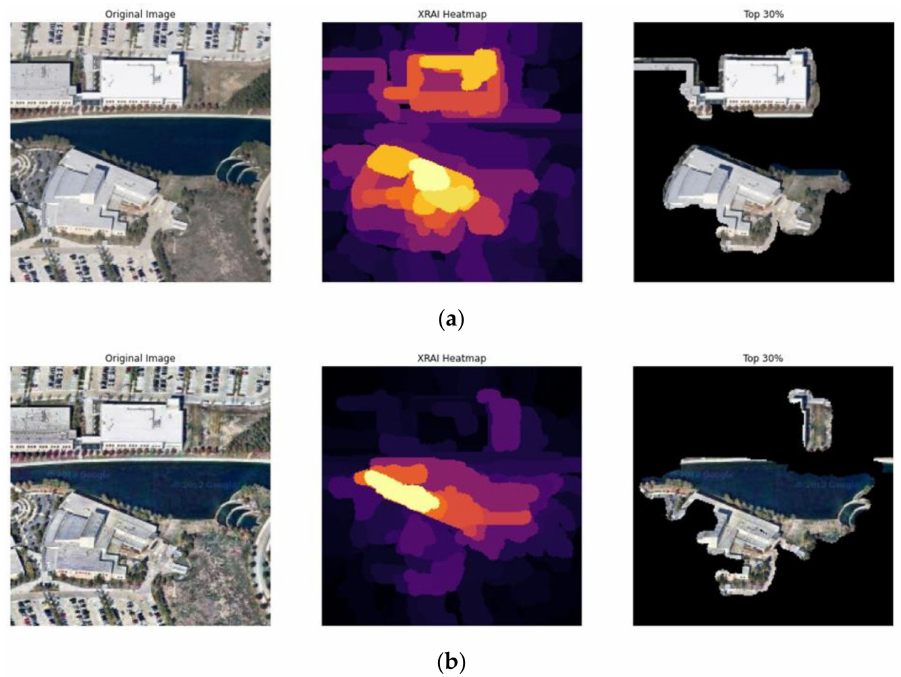
Figure 13. Image (river/lakes category) with XRAI analysis. ( a ) Original image (predicted as Industry); ( b ) improved